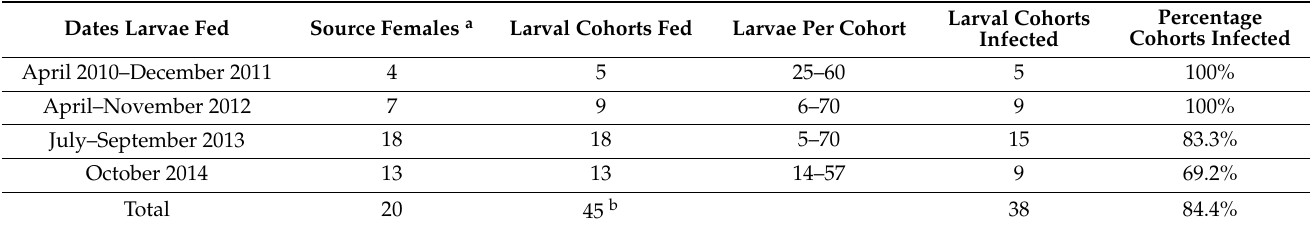
Table 3. Assessment of transovarial infection of O. hermsi larvae with B. hermsii by feeding larval cohorts on mice at different times after tick